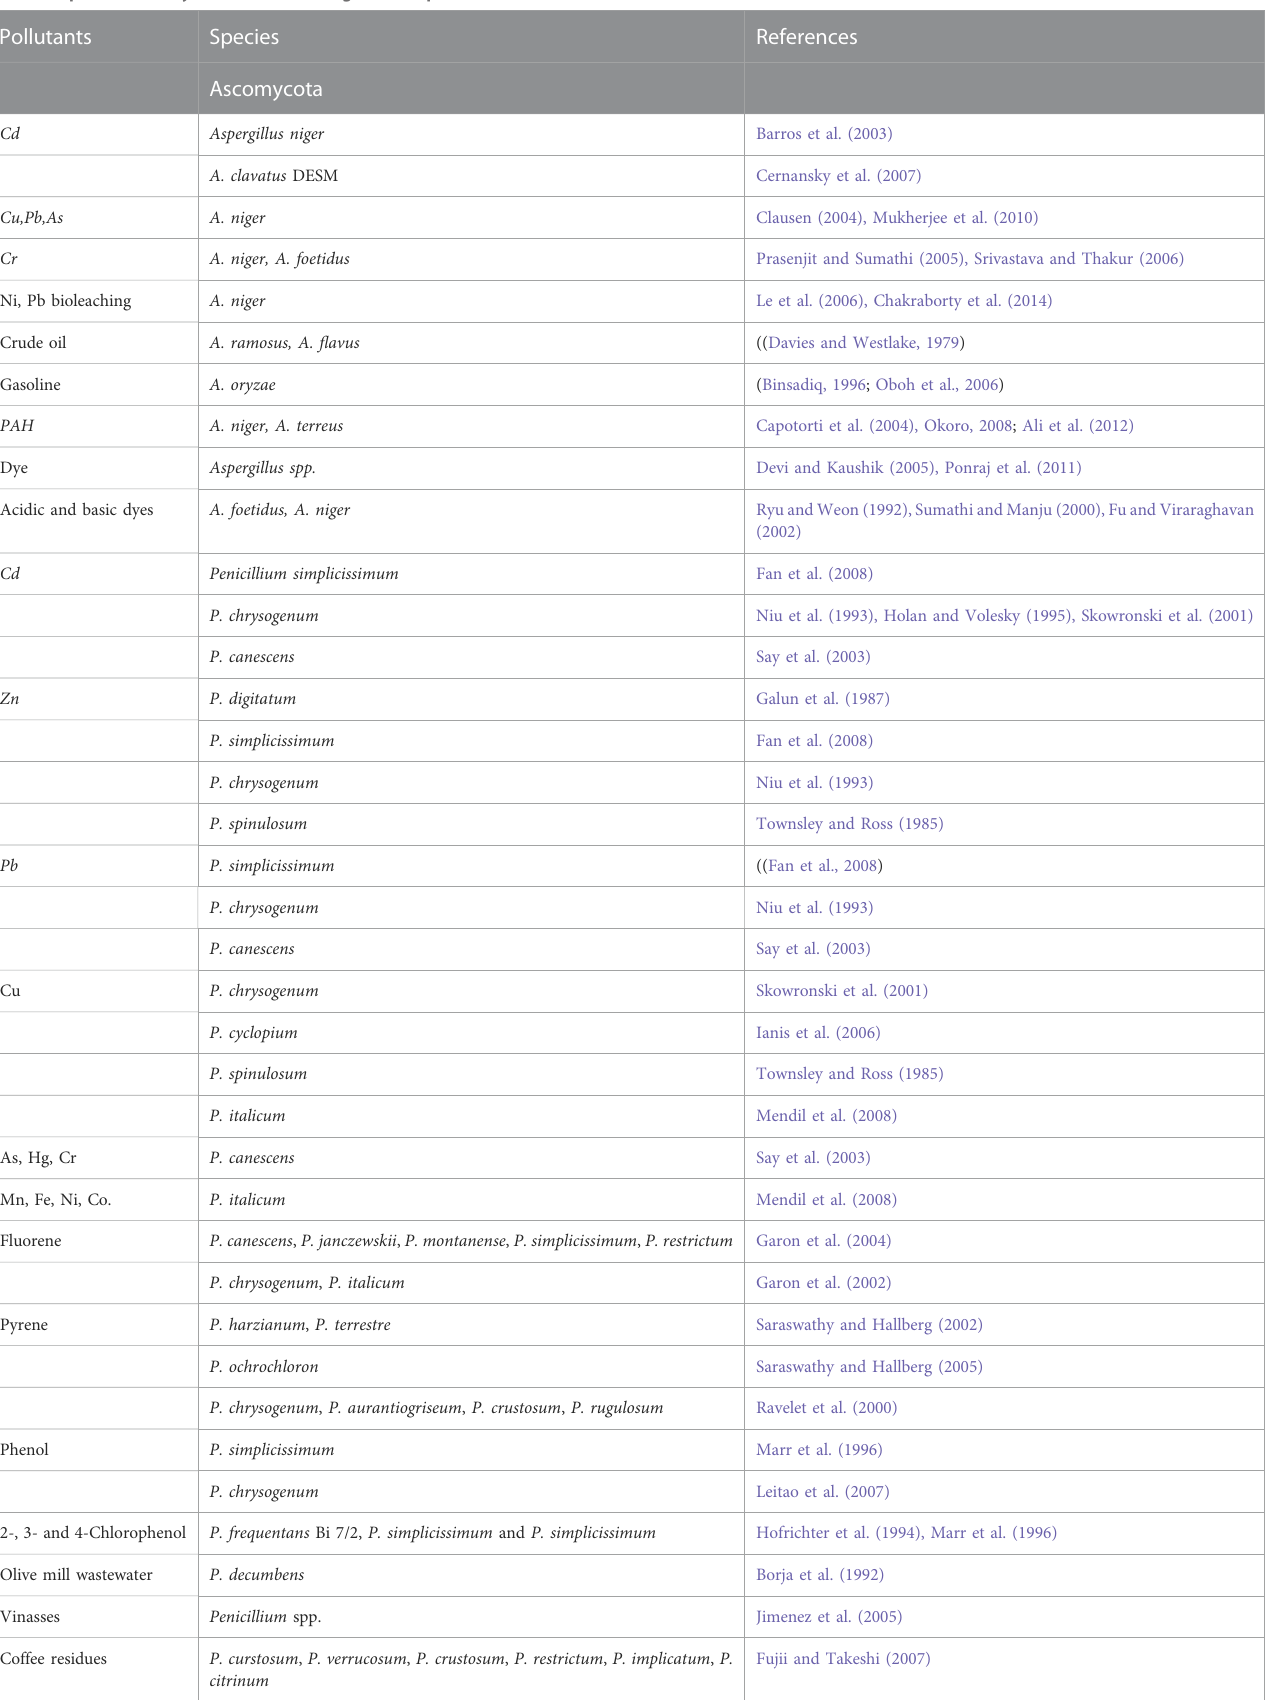
TABLE 1 Species diversity of fi lamentous fungi used in pollutant